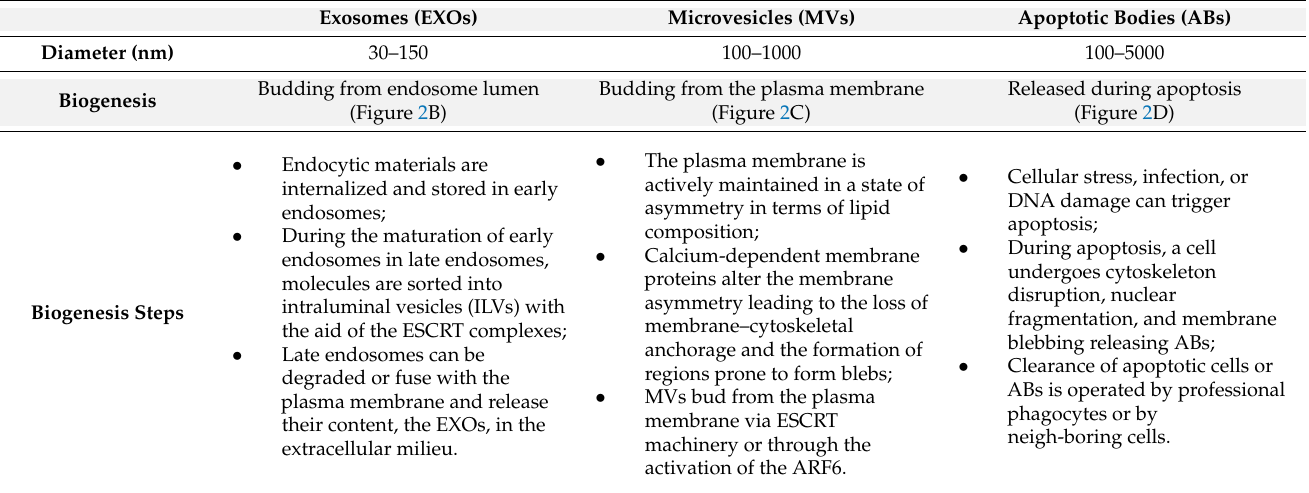
Table 1. EV classification and biogenic